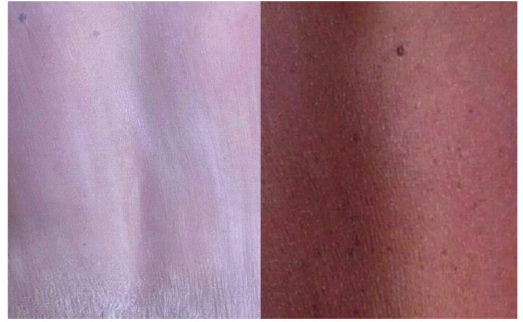
Figure 3. Side by side comparison of traditional and nanosized zinc oxide sunscreen. Photos showing appearance of the skin after six applications of non-nanosized ( left ) and nanosized ( right ) ZnO sunscreens. Adapted with permission from Oxford University Press, 2010